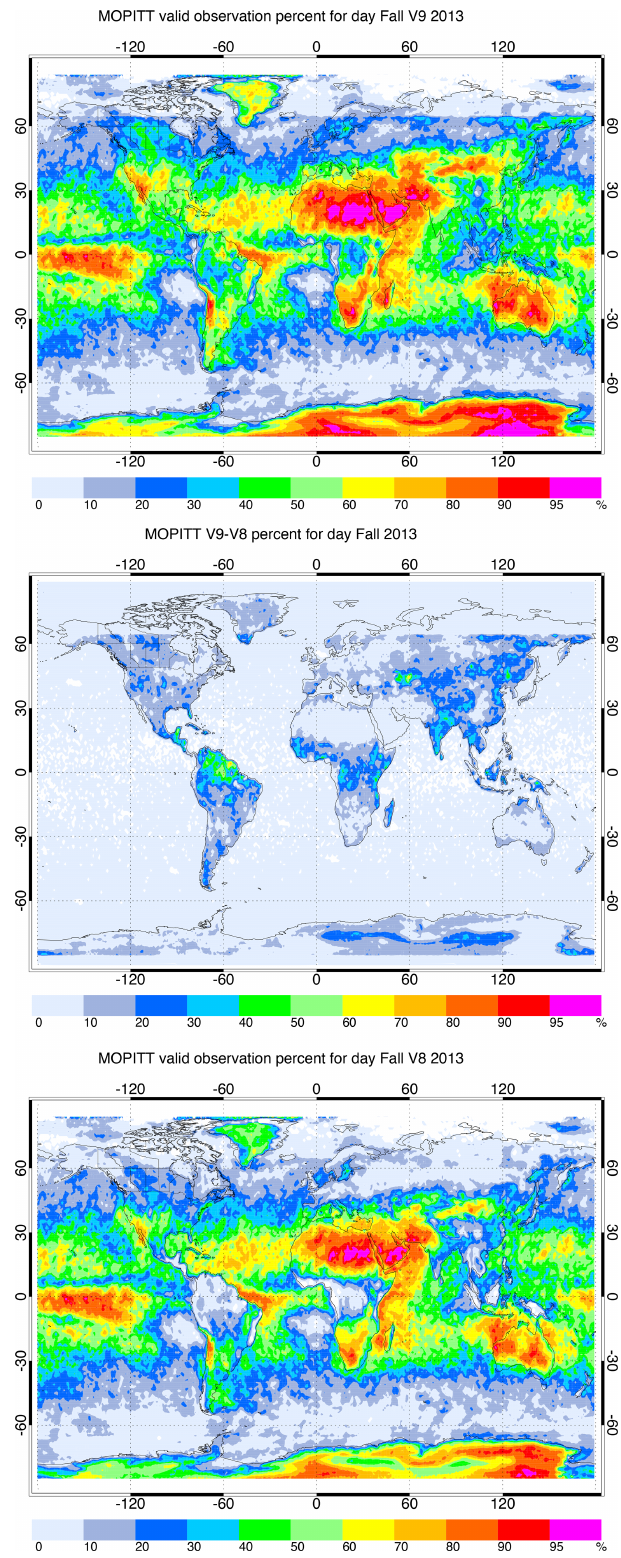
Figure 5. The same as Fig. 2 but for the fall